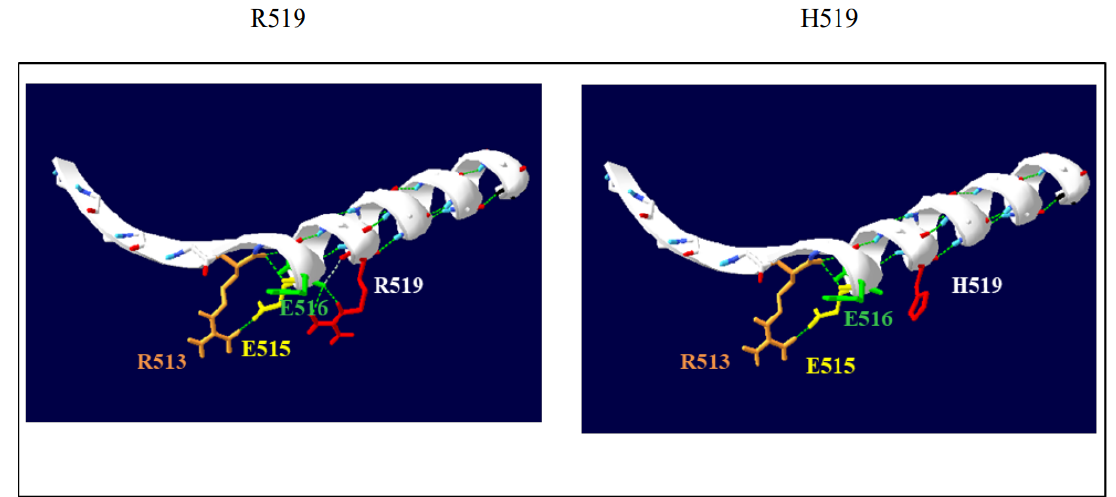
Figure 3. Comparison of the predicted structures of both wild-type (R519) and mutant protein (H519) using SwissPdbViewer (https://spdbv.unil.ch/ (accessed on 18 November 2022)); H-bonds are displayed as green dotted lines in the mutant